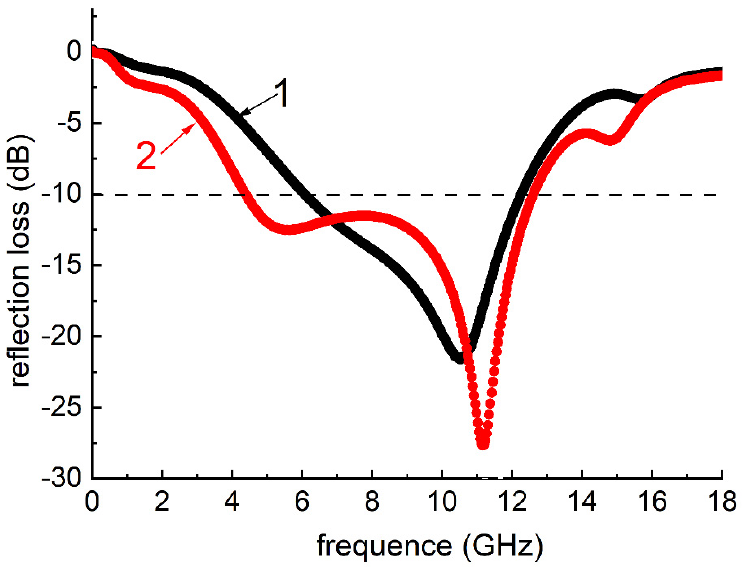
Figure 8. Spectra of reflection loss: 1—sample N1 (black), 2—sample N2 (red). The measurements were carried out in a short-circuited coaxial cell. The RL value from the untextured sample N1 is less than − 10 dB in the 6.1–12.2 GHz band. The textured